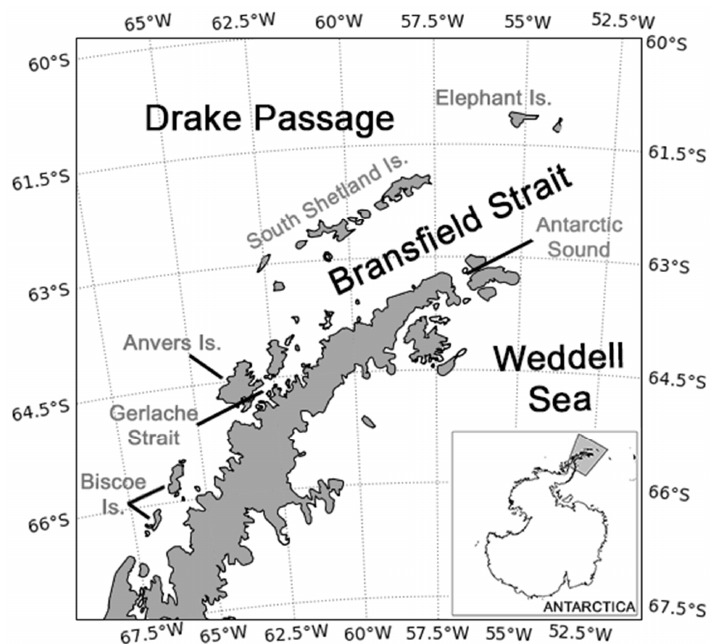
Figure 1. The Western Antarctic Peninsula’s main features, and other locations referenced in this work.